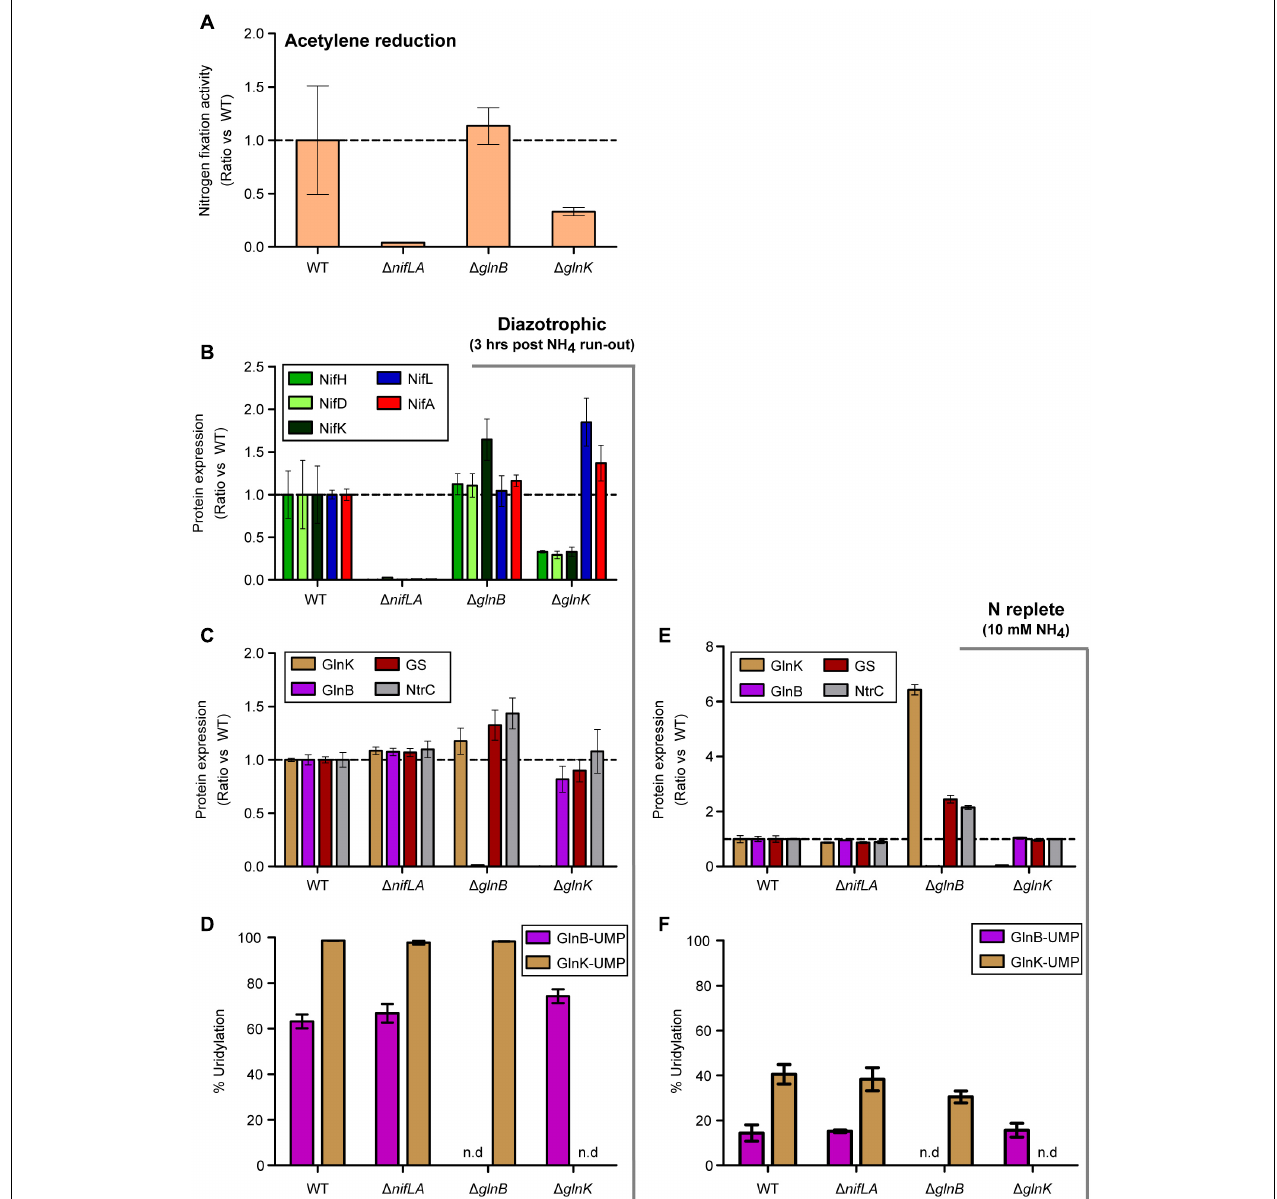
FIGURE 7 | Effects of (cid:49) glnB and (cid:49) glnK knockout mutations on diazotrophy. Ko M5a1 wild-type, (cid:49) nifLA , (cid:49) glnB , and (cid:49) glnK strains were cultured for 3 h following run-out of 0.5 mM NH 4 Cl in NFDM medium. Fold-change in various parameters with respect to wild-type: (A) Nitrogen fixation activity. Culture headspace was analyzed for ethylene evolution via the acetylene reduction assay. (B) Nif protein abundance. Extracted cell protein was supplemented with a mix of four QconCAT standards, trypsin digested, and the derived peptides analyzed via LC–MS. The absolute copy numbers of NifHDK (green shades) and NifLA (blue, red) were inferred from the sample/QconCAT peak area ratio for quantotypic peptides and QconCAT concentration, assuming an OD600 of 1.0 = 10 9 CFU mL − 1 and a cell volume of 10 − 15 L. (C,E) Ntr protein abundance. The absolute copy numbers of GlnK (brown), GlnB (pink), GS (maroon), and NtrC (gray). Dashed lines correspond to no fold change relative to wild-type. (D,F) PTM uridylylation status of PII-type proteins. Percentage uridylylation of GlnK (brown) and GlnB (pink) was inferred from